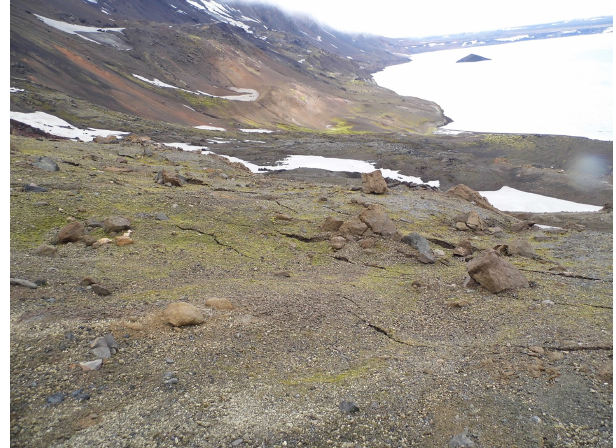
Figure 3. Surface opening cracks on top of the landslide body in August 2013, a year before the failure. Location of the image is indicated in Fig. 5e; view is to the west. Image taken by Daniele